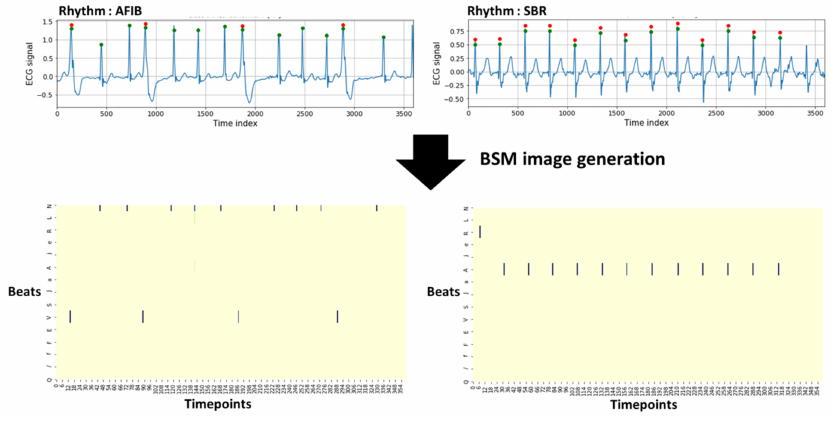
Figure 2. BSM image generation of an ECG